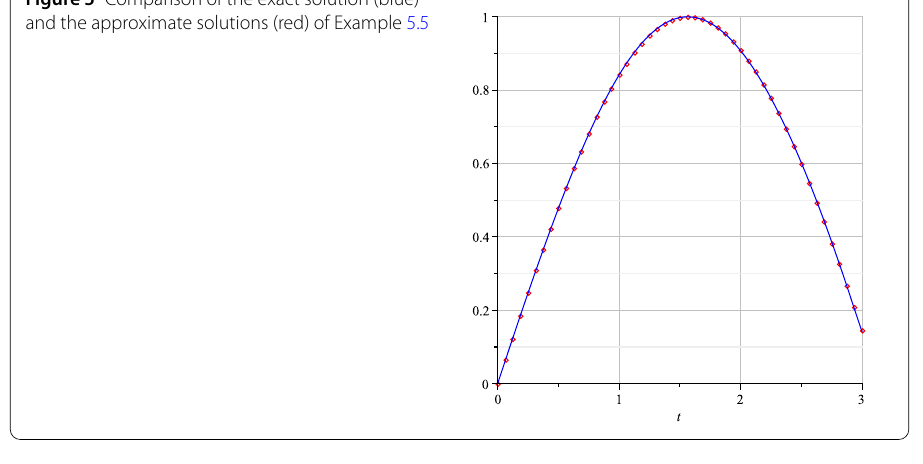
Figure 5 Comparison of the exact solution (blue) and the approximate solutions (red) of Example 5.5